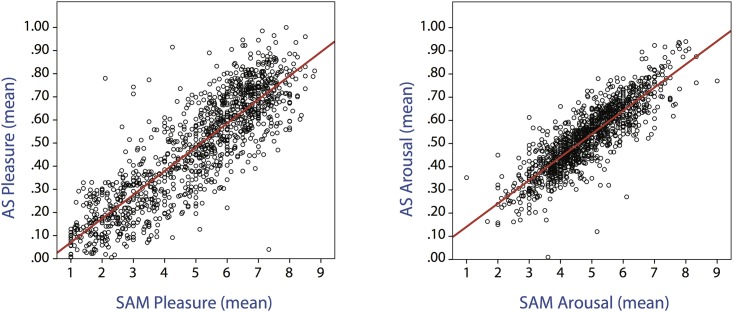
Scatterplots representing the linear correlation between AS and SAM pleasure (rs = .852) and arousal (rs = .860).The red line indicates the best fit.